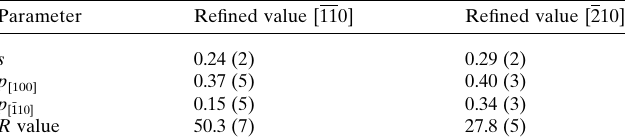
are the percentages of the 1110 (cid:8)